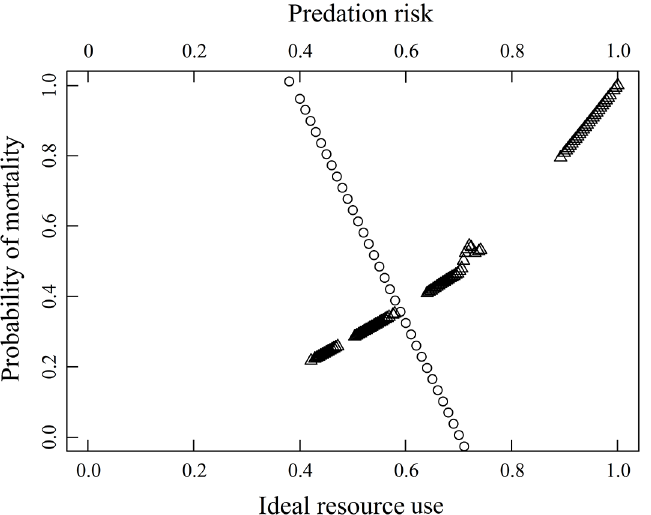
Fig 2. Cox-proportional hazards mixed-effects model assessing seasonally-averaged probability of mortality with ideal resource use (circles) and predation risk (triangles) of white-tailed deer fawns ( (cid:1) 14 weeks of age; Odocoileus virginianus ; n = 129) captured as neonates during the maternal dependency period (14 May – 31 August), southcentral Upper Peninsula of Michigan, USA, 2009 –